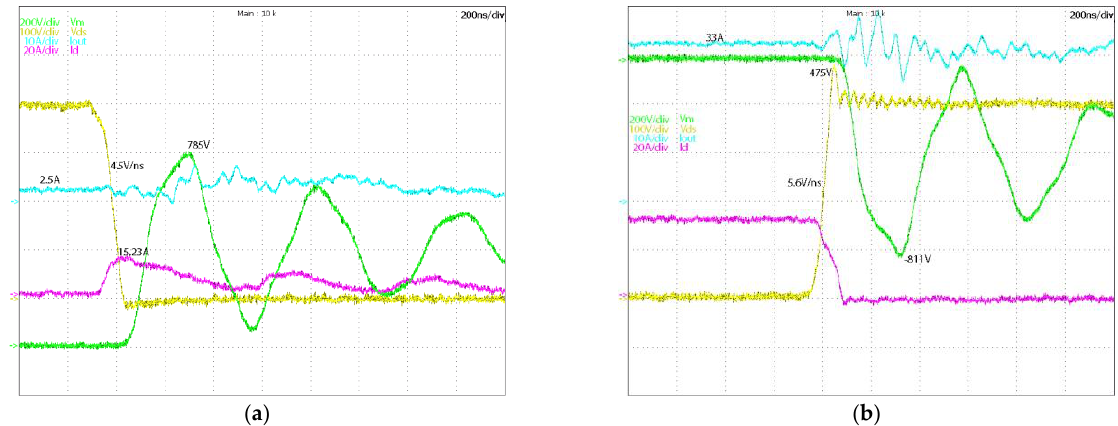
Figure 10. Commutation of S A,t located in the three-phase 2L inverter with R G = 22 Ω, dead-time DT = 1 µs, switching frequency f sw = 10 kHz and l C = 15 m: ( a ) turn-off, ( b ) turn-on. Line-to-line voltage V m at the motor side (green track), drain-source voltage V DS of the S A,t (yellow track), drain current of S A,t (magenta track) and phase current I A (ciano track).